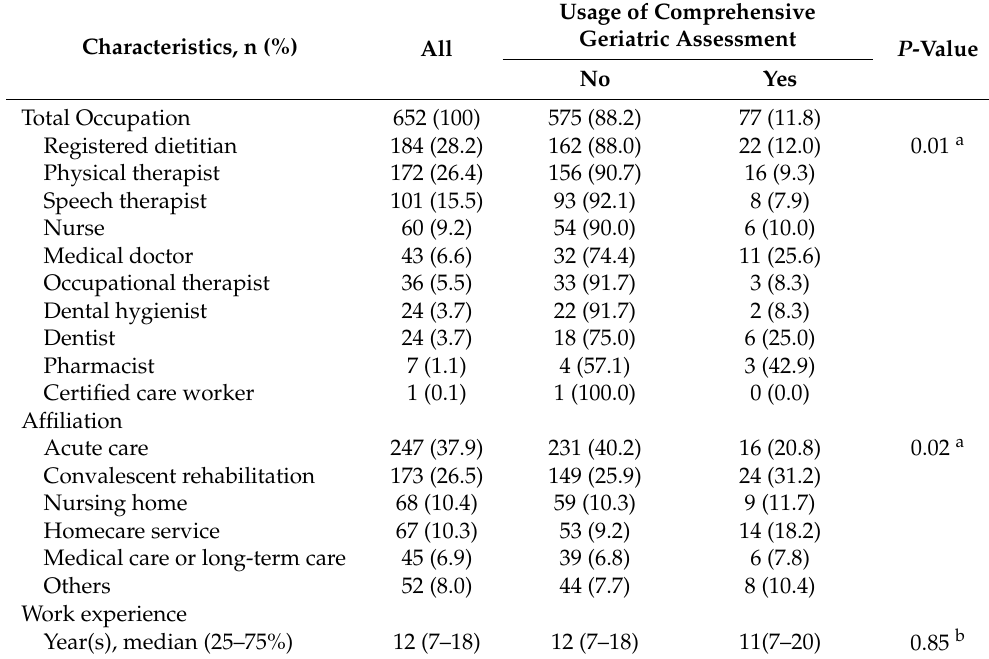
Table 1. Demographic Characteristics of